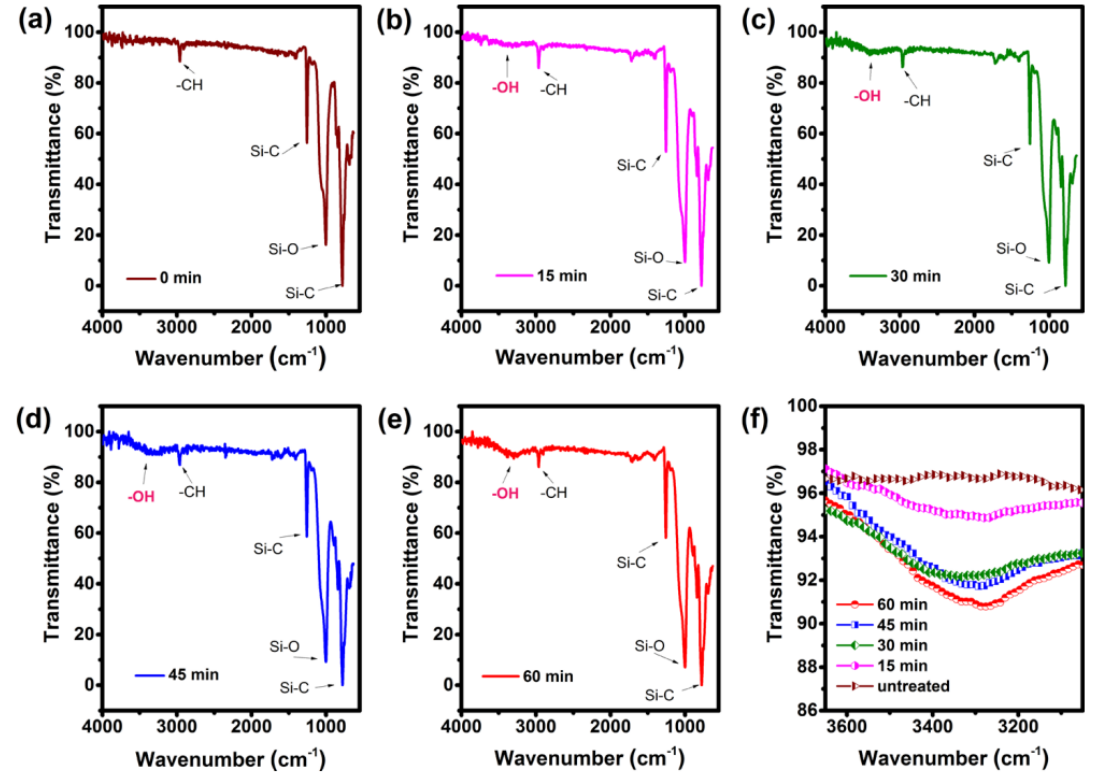
Figure 8. ATR − FTIR spectra of ( a ) untreated PDMS, ( b ) 15 min UVO exposure, ( c ) 30 min UVO exposure, ( d ) 45 min UVO exposure, ( e ) 60 min UVO exposure and ( f ) OH peaks at different UVO exposure times. Reprinted with permission from [94]. Copyright 2018 American Chemical